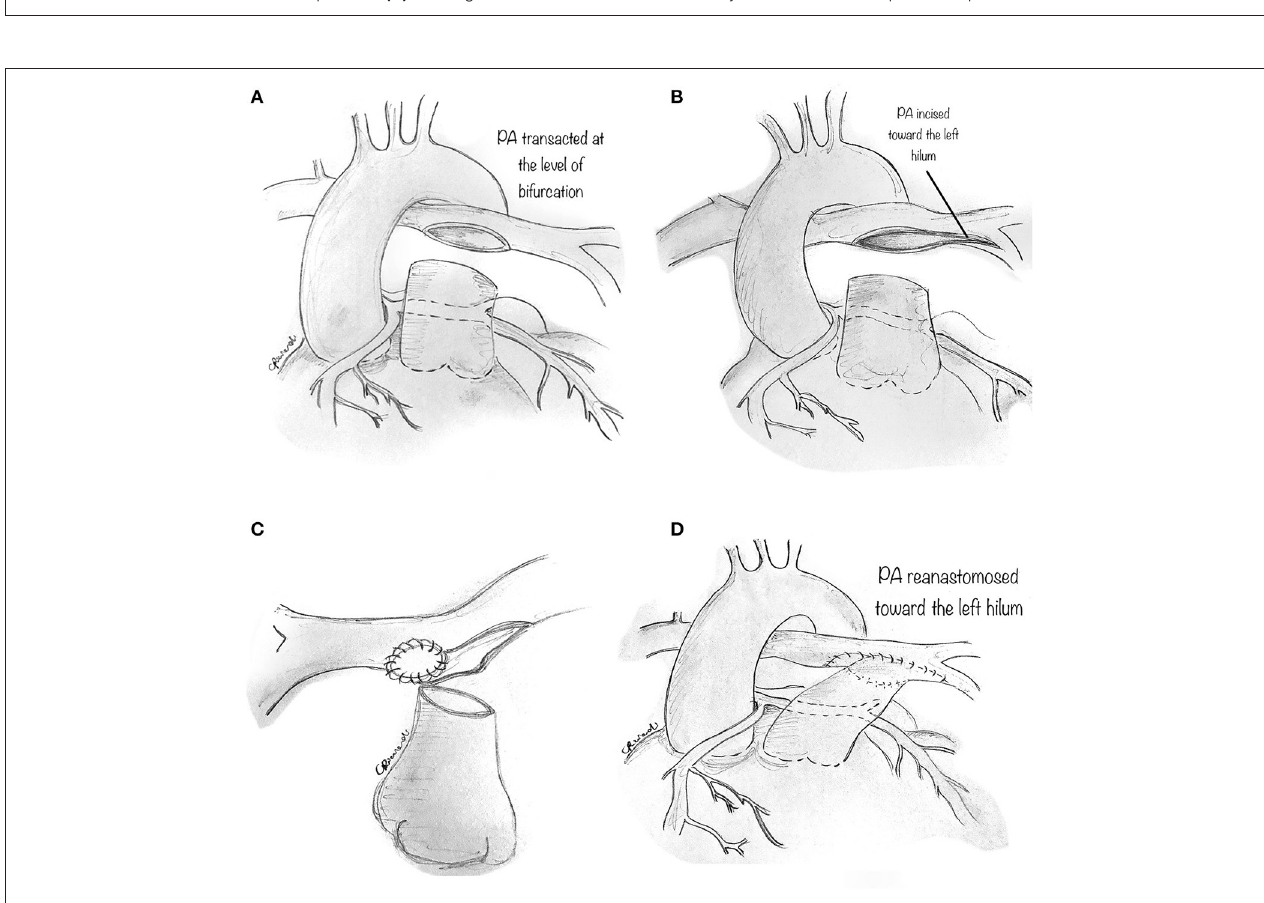
FIGURE 9 | Pulmonary artery translocation technique. (A) The perivascular soft tissue between the aorta and the pulmonary artery is debulked. The distal main pulmonary artery is carefully transected at the bifurcation. (B) The left pulmonary artery (PA) is incised toward the left hilum. (C) A prosthetic material (pulmonary homograft or heterologous pericardium) is then fashioned to widely patch the opening in the PA confluence so as to avoid right PA stenosis. (D) The main PA is then re-anastomosed toward the left hilum, resulting in a widely patent PA and pulmonary branches.